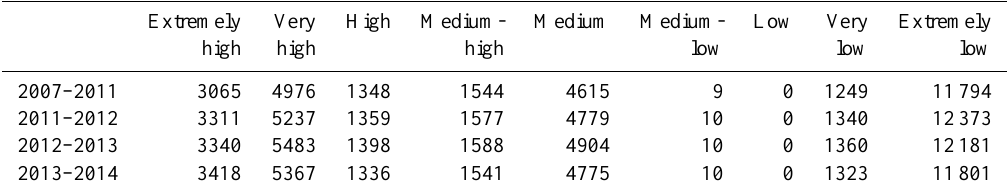
Table 3. CVI points assessed for each survey period per subsidence risk class. Extremely Very High Medium- Medium Medium- Low Very Extremely high high high low low